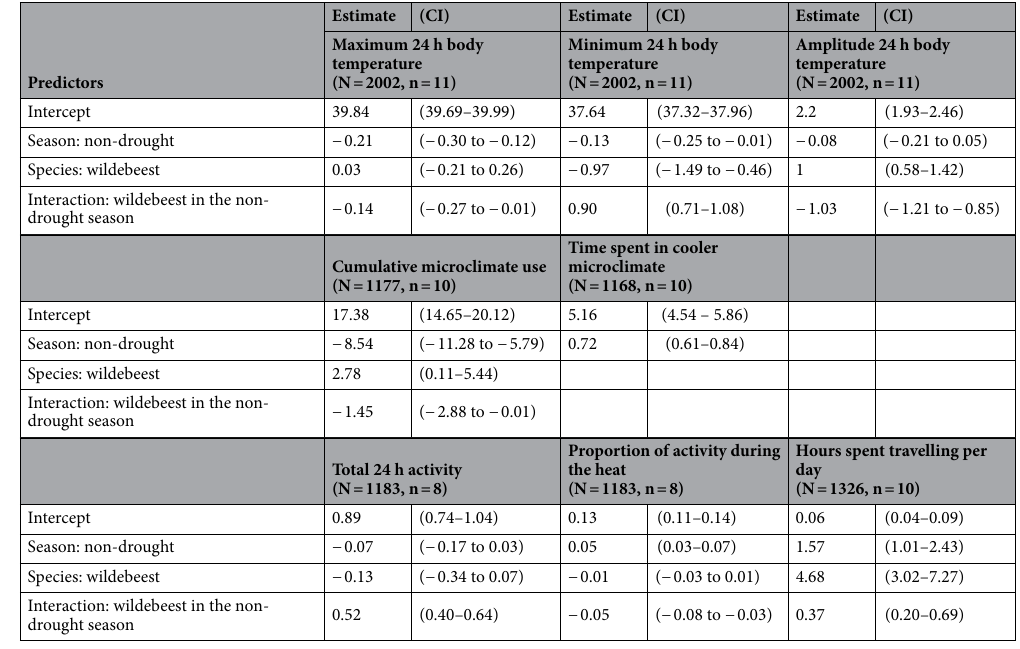
Table 2. Results of Generalised Linear Mixed Models comparing the 24 h body temperature parameters, cumulative microclimate use, time spent in cooler microclimates, total 24 h activity, proportion of activity during the heat of the day (10:00 to 16:00), and number of hours spent travelling per day for gemsbok and wildebeest during the hot-dry seasons of the two successive years, as well as the interaction effects. The estimates and confidence intervals (CI) reported are for the non-drought hot-dry season, wildebeest, and the interaction for wildebeest in the non-drought season compared to the reference levels: drought, gemsbok, and gemsbok in the drought. The presented models are the most parsimonious of a general model (Supplementary Table 1). Date and individual animal were included as random